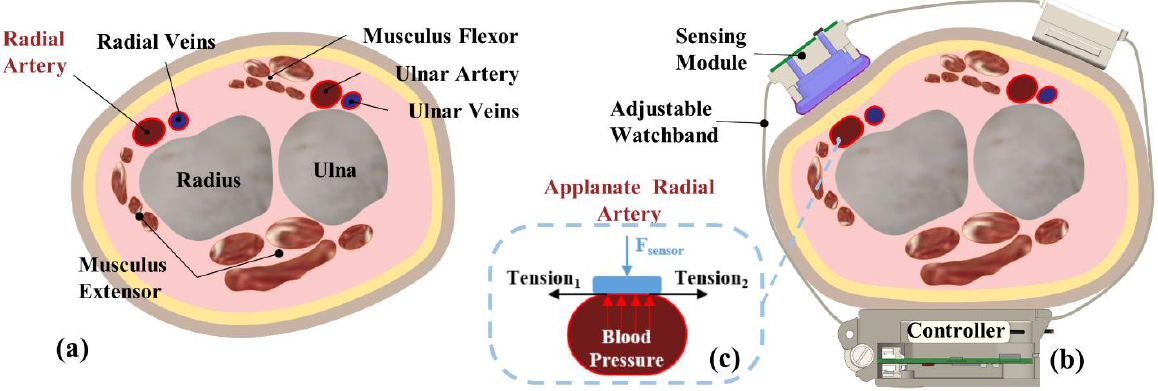
Figure 2. Schematic of arterial tonometry: ( a ) cross section of the human wrist; ( b ) device wearing schematic; ( c ) applanate radial artery.